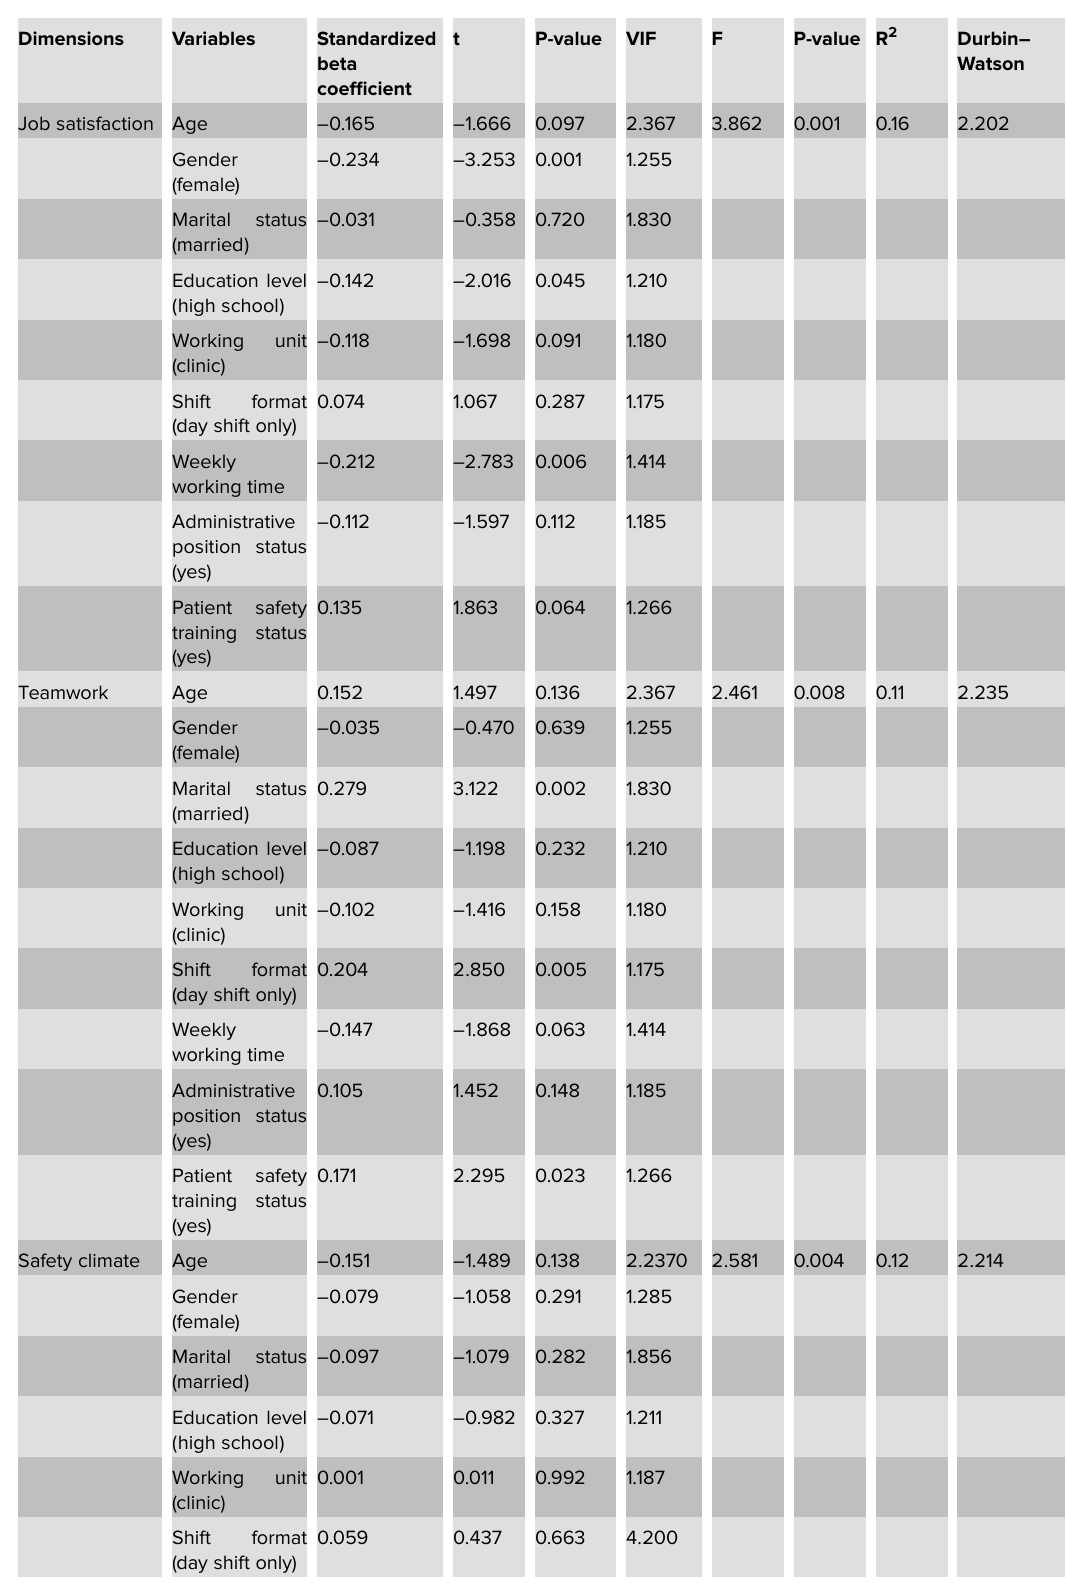
Table 4: Patient safety attitude regression analysis